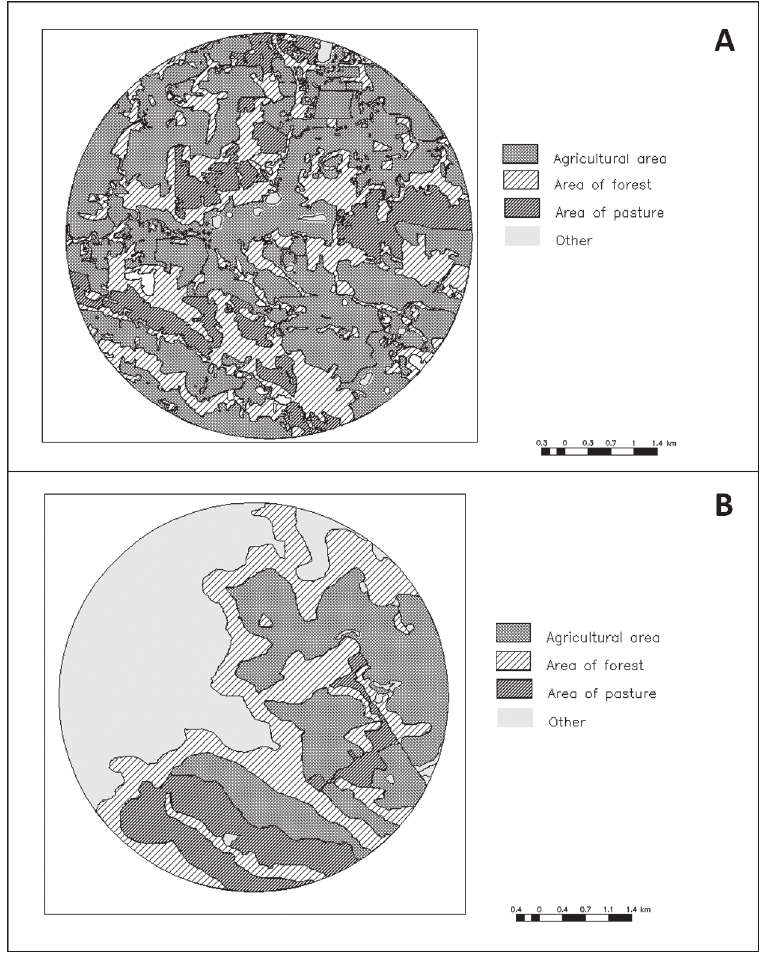
Figure 2 - Use and occupation of soil in a hive in the counties of: A) Marechal Cândido Rondon and B) Santa